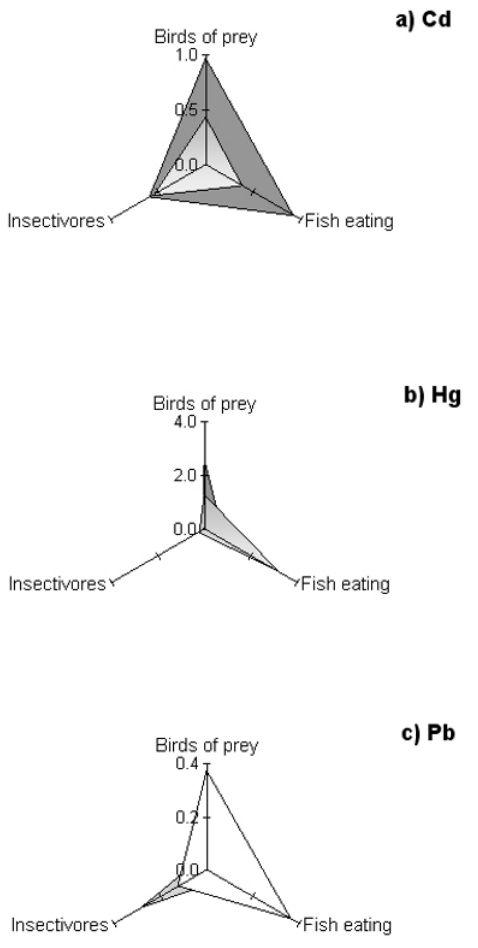
Figure 2. Comparative Cd, Hg and Pb concentrations in liver, kidney and bone samples of